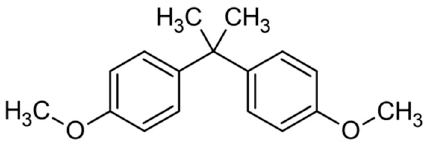
Figure 1. Chemical formula of bisphenol A (BPA).